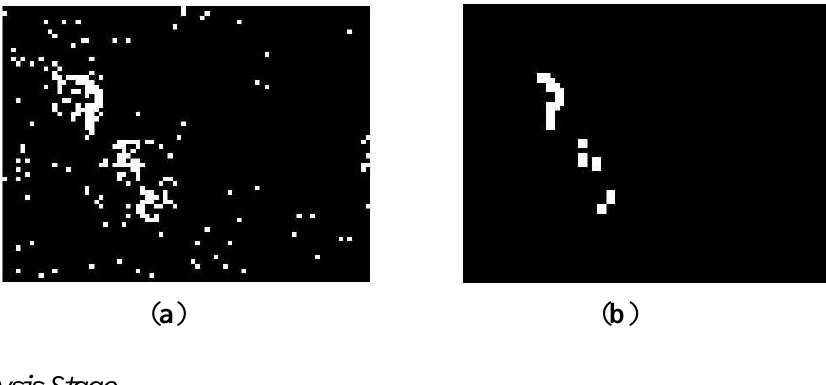
Figure 3. Noise reduction by morphological opening operation. ( a ) binary image obtained by Equation (17) and ( b ) binary image after morphological